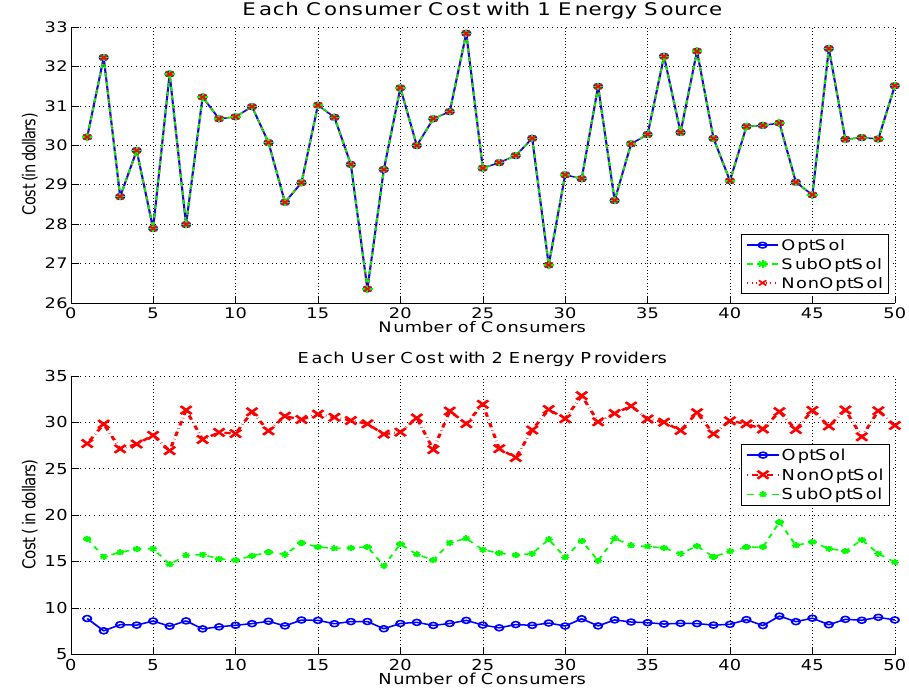
Figure 7. Fair Cost Minimization versus Number of Energy Sources for N = 1 and N =